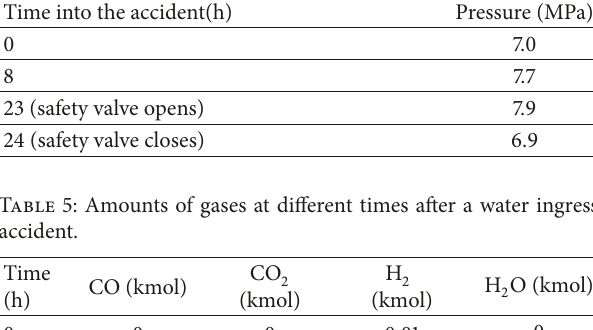
Table 4: Variation in pressure during a water ingress accident. Time into the accident(h)